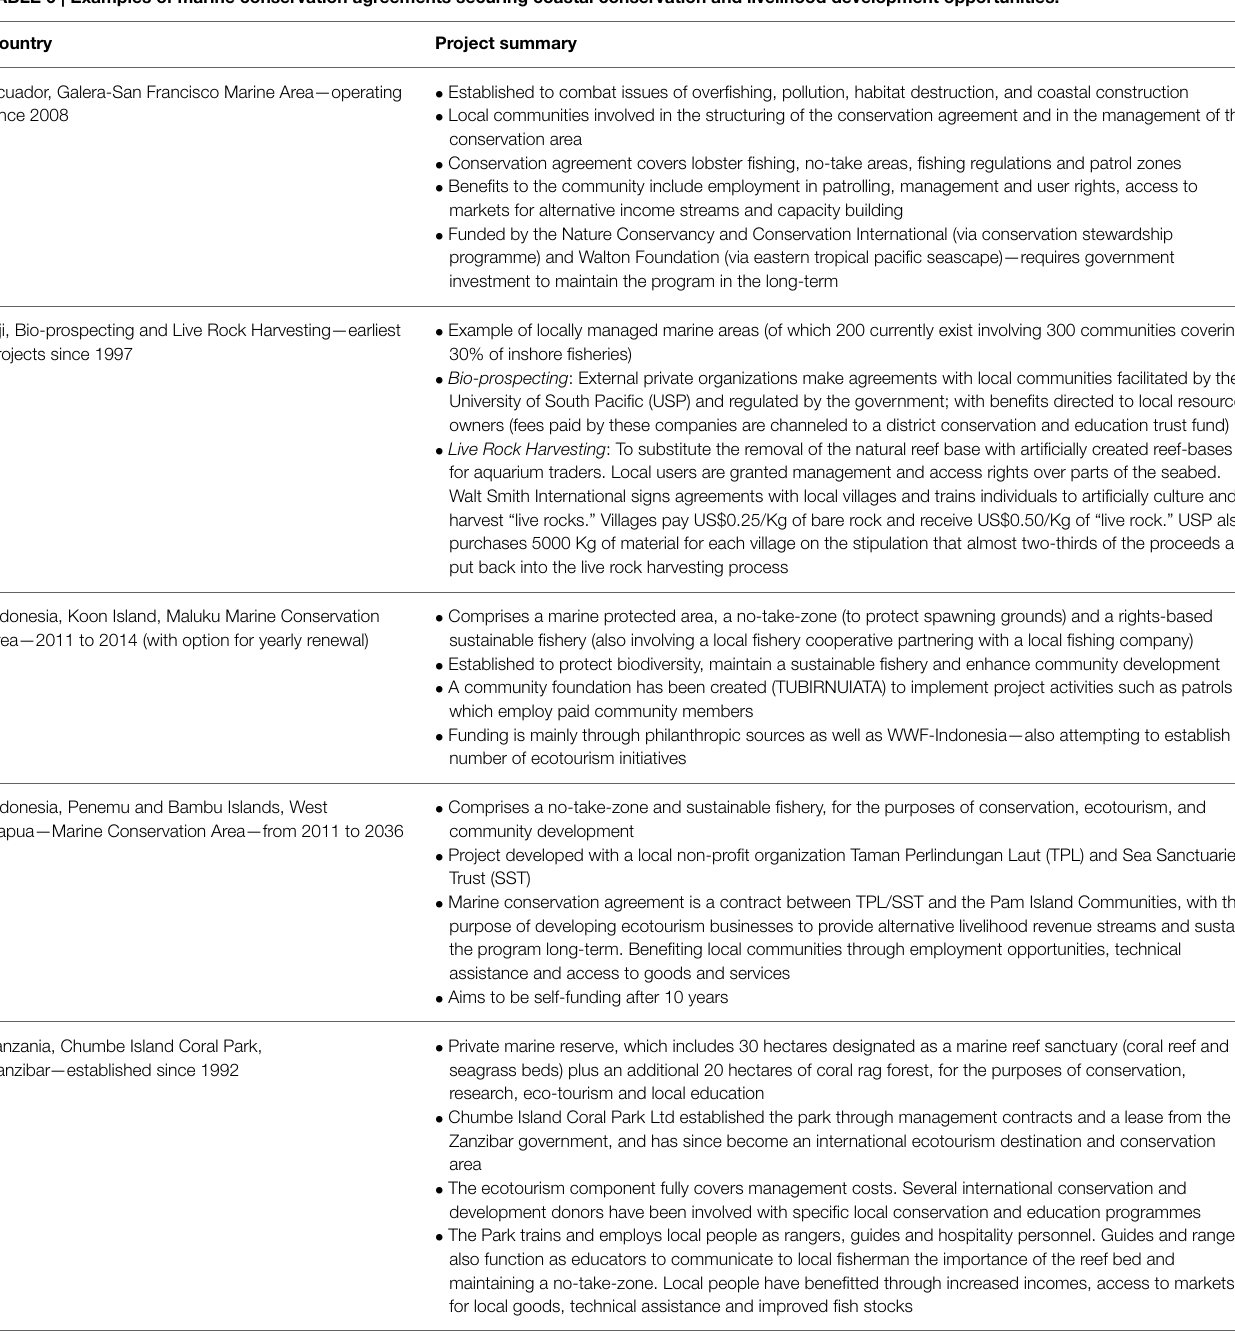
TABLE 6 | Examples of marine conservation agreements securing coastal conservation and livelihood development opportunities.